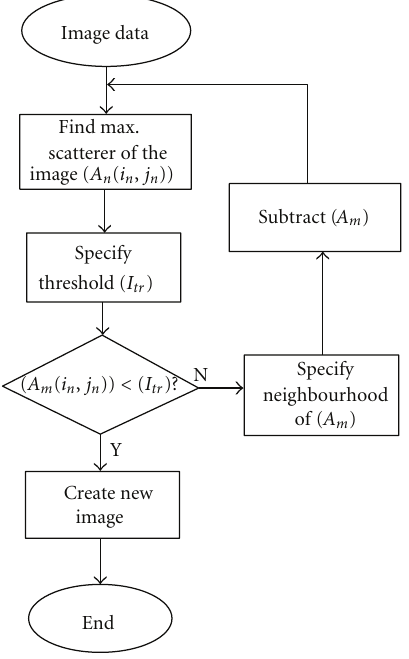
Figure 2: The flowchart of the CLEAN